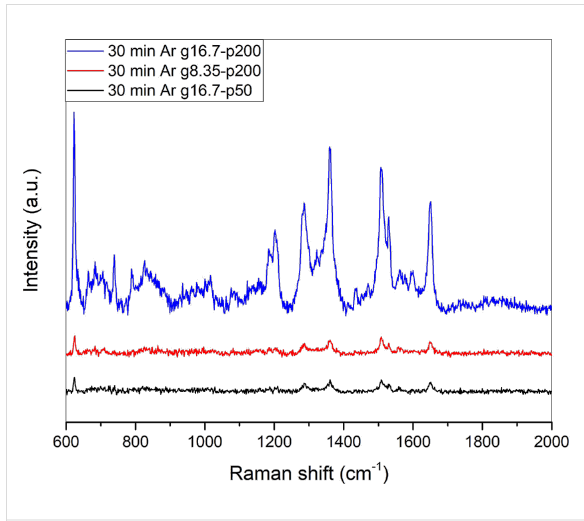
Figure 13: SERS spectra of 10 − 6 M RhB on a 200 nm silver film treated with argon plasma for 30 min using different parameters under 632.8 nm laser